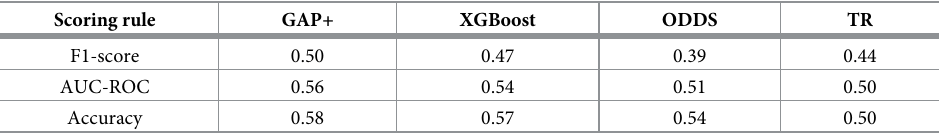
Table 5. Match results forecasting performance.